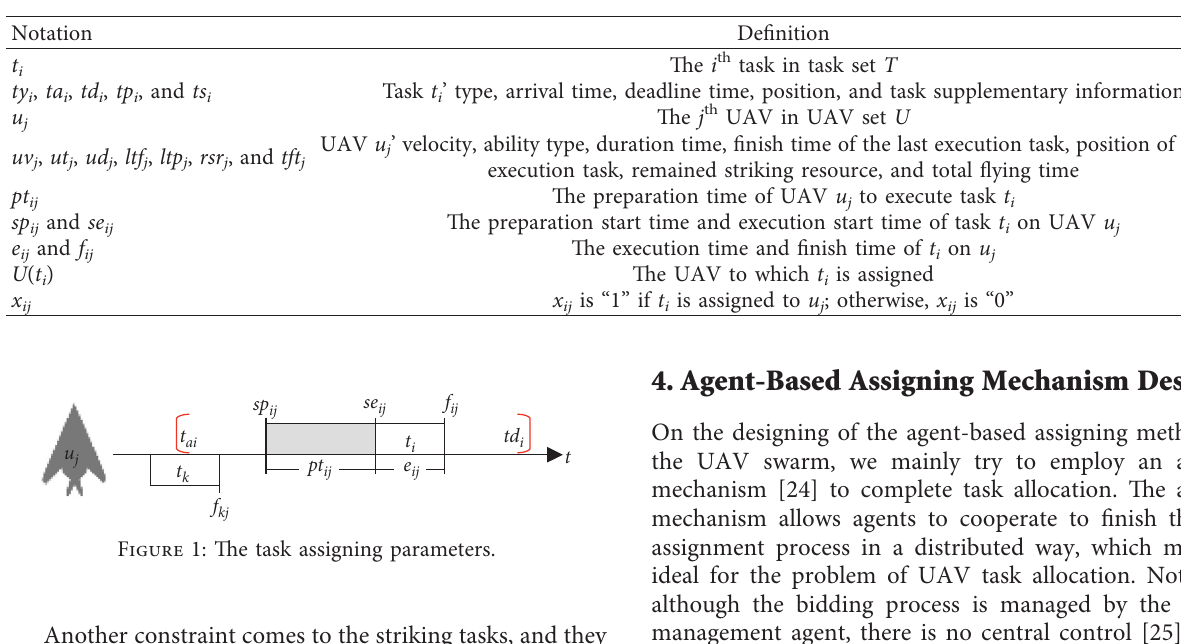
Table 1: Definition of main notations.